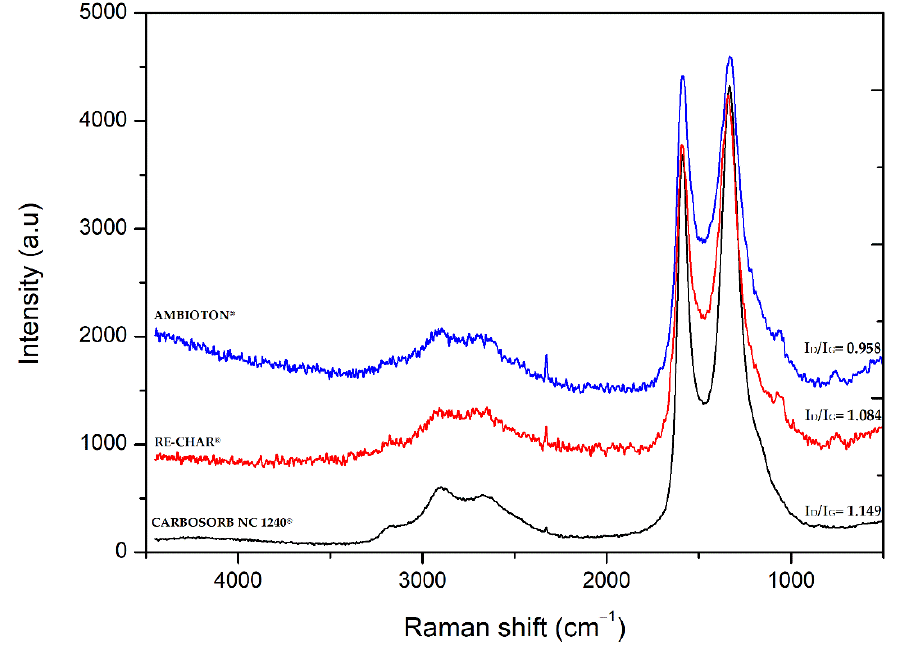
Figure 5. Raman spectra of carbonaceous materials. CARBOSORB NC 1240 ® , AMBIOTON ® , and RE-CHAR ® .